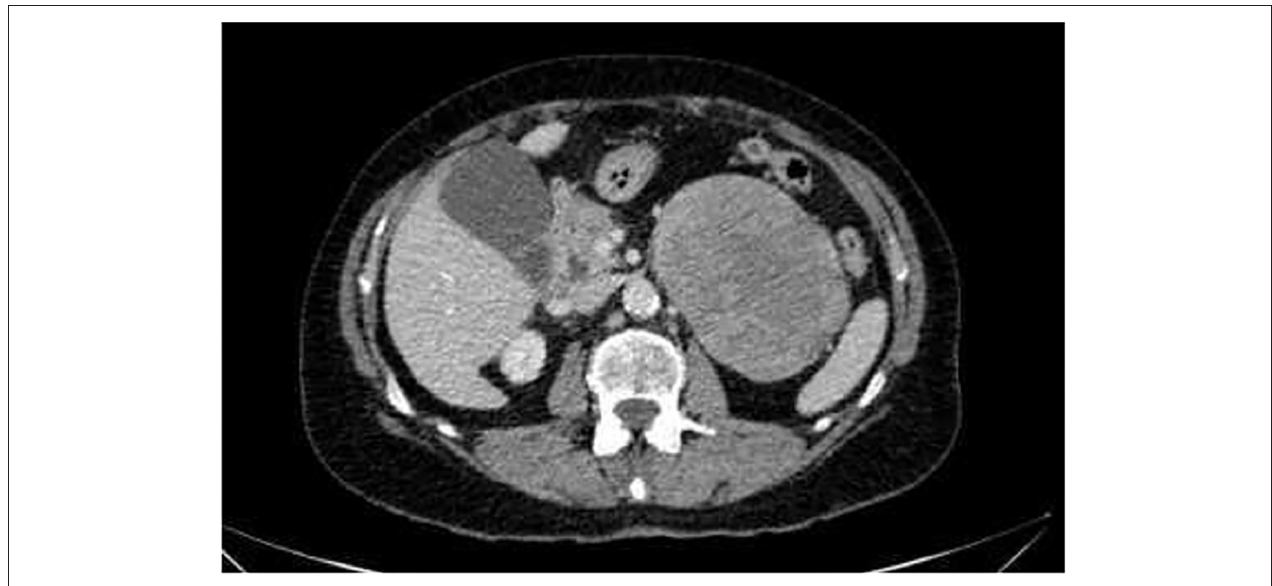
FIGURE 1 | CT-scan of the abdomen. Axial CT scan of the abdomen reveals a large abdominal mass measuring 10 × 8 × 10cm without lymphadenopathy.